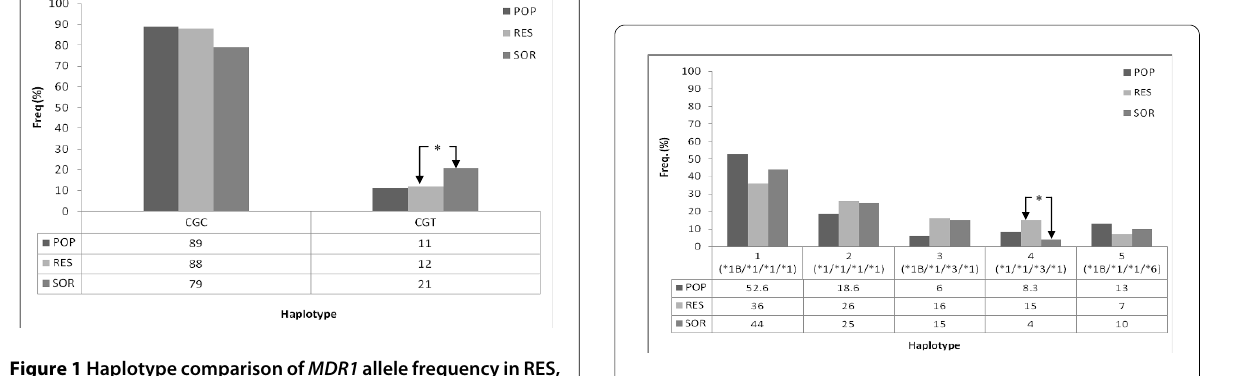
Figure 2 Haplotype comparison of CYP3A4 and CYP3A5 allele frequency in RES, SOR and POP . * p < 0.05; FET. RES verses SOR; hap- lotype 4 (*1/*1/*3/*1) was significantly different POP = Random Ghanaian population, RES = responders, SOR = Suboptimal